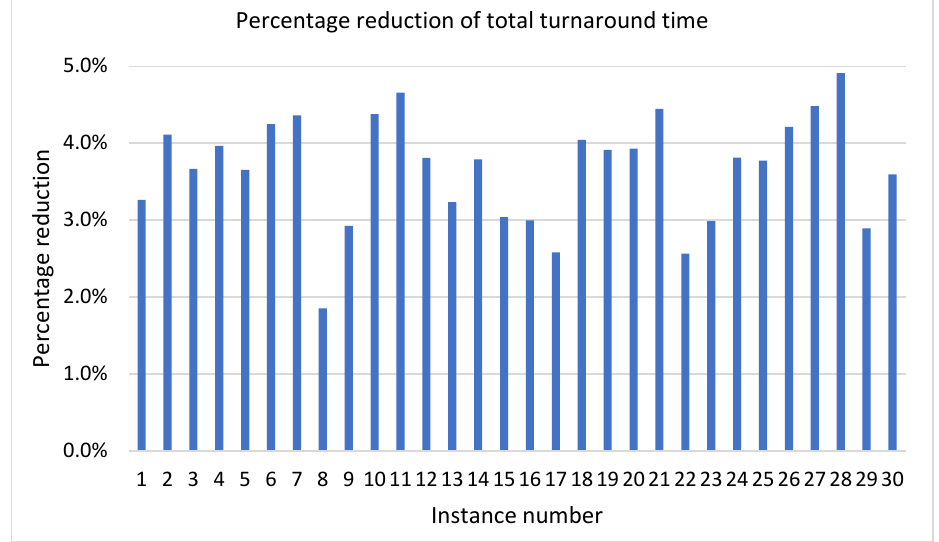
Figure 19. The total TTT before and after leveling the workload for all instances.